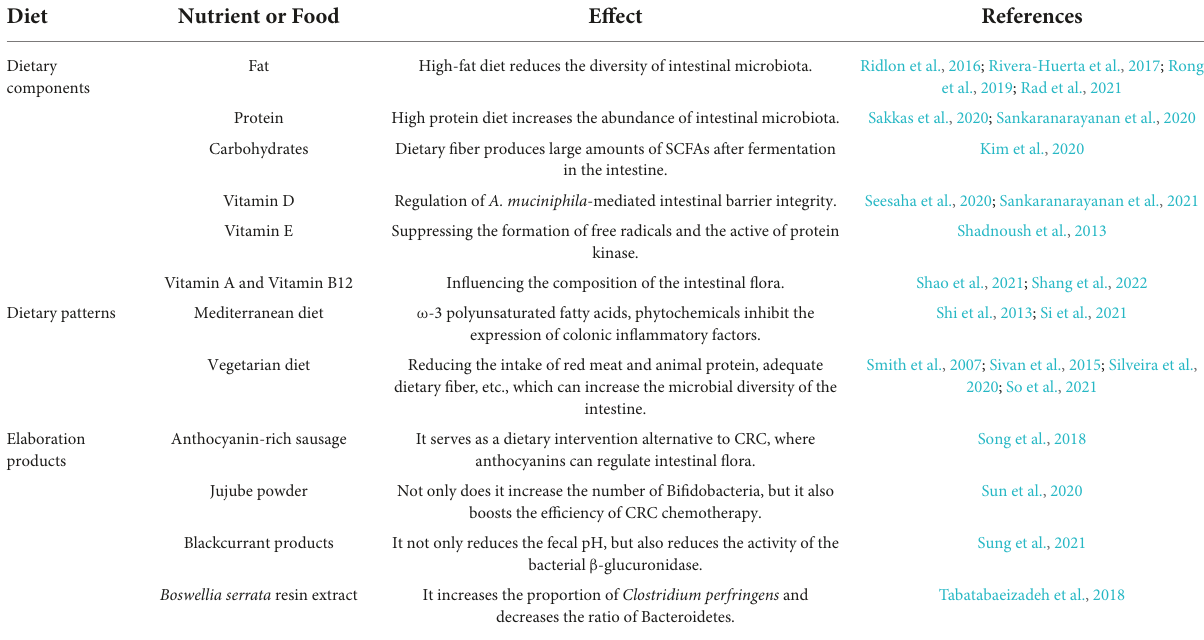
TABLE 3 The chart summarizes how different dietary components, dietary patterns, and some elaboration products affect gut microbiota and thus play a role in preventing